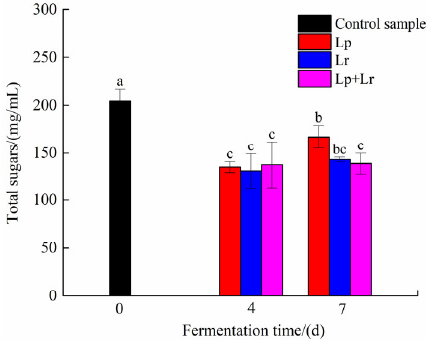
Figure 2. Total sugar content of edible grass during fermentation. Different superscript letters in the columns indicate significant difference ( p < 0.05). Abbreviations: Lp, Lactobacillus plantarum ; Lr, Lactobacillus rhamnosus ; Lp+Lr, mixture of Lactobacillus plantarum and Lactobacillus rhamnosus